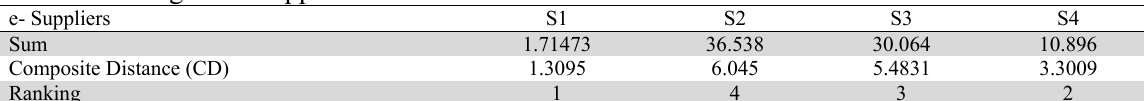
Overall Ranking of E- Suppliers e- Suppliers